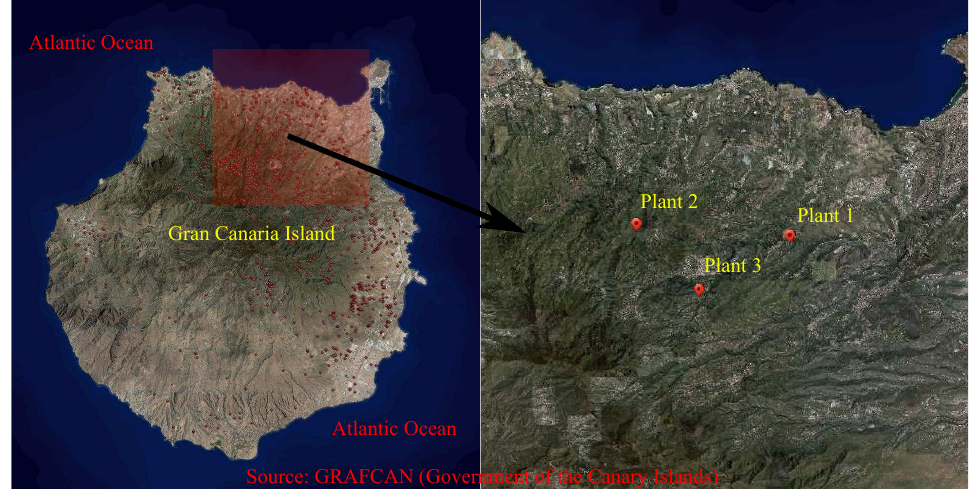
Figure 4. Location of the plants in Gran Canaria